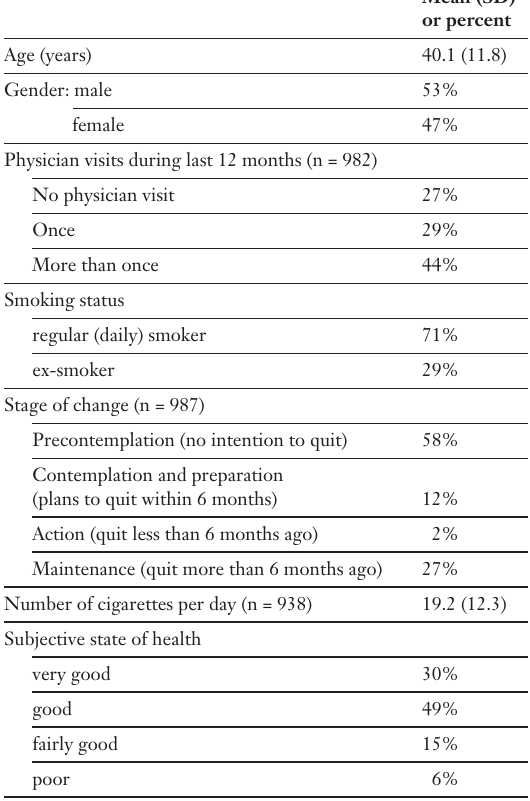
Doctor has asked about smoking, ad- vised patient to quit, and patient expects doctor to ask, in relation to different